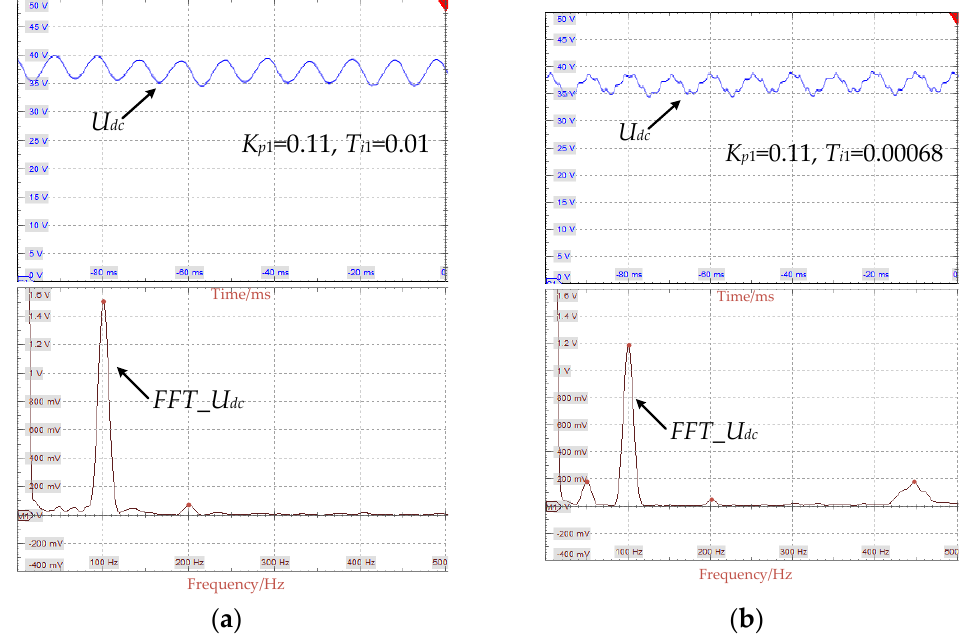
Figure 10. Experimental waveform and FFT analysis results of dc bus voltage u dc in CS at ( a ) [ K p 1 , T i 1 ] = [0.11, 0.01]; ( b ) [ K p 1 , T i 1 ] = [0.11, 0.00068].